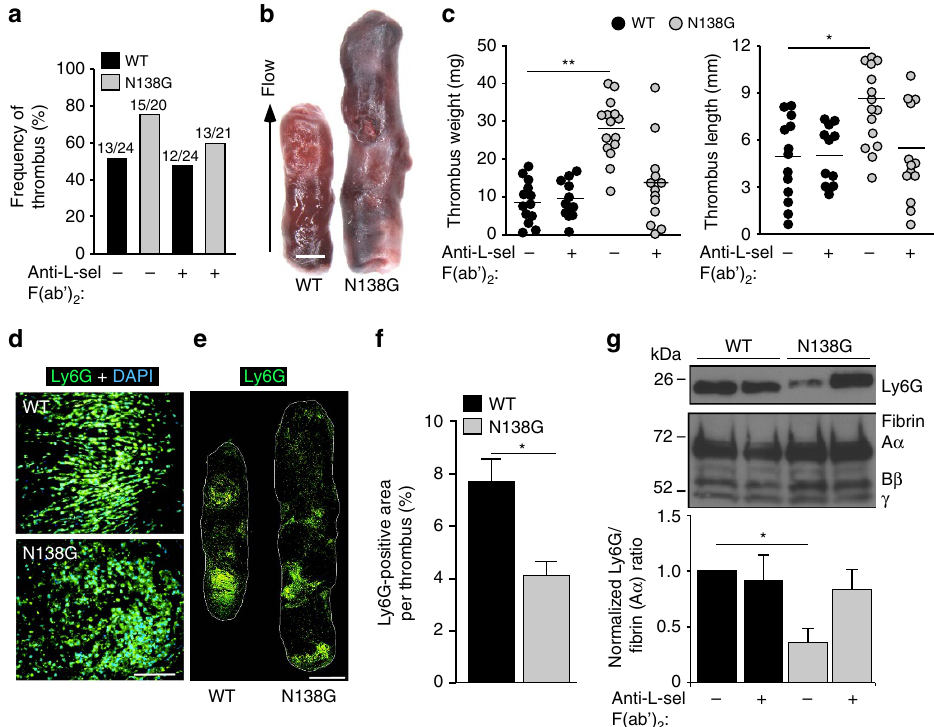
Figure 7 | N138G mice form larger deep vein thrombi. ( a ) Frequency of thrombi formed in inferior vena cava 48h after flow restriction in WTand N138G mice treated with or without anti-L-selectin F(ab 0 ) 2 . For each experimental group, the number of mice forming thrombi relative to the total number of mice is shown. ( b ) Representative thrombi. Arrow indicates direction of blood flow. Bar, 1mm. ( c ) Thrombus length and weight in WTand N138G mice treated with or without anti-L-selectin F(ab 0 ) 2 . Each symbol represents an individual thrombus. Horizontal bars represent median values. ( d ) Representative cryosections of leukocyte-rich areas of thrombi stained with anti-Ly6G mAb to identify neutrophils and with DAPI to identify cell nuclei. Bar, 100 m m. ( e ) Stitched cryosections of entire thrombus stained with anti-Ly6G mAb. Bar, 1mm. ( f ) Percentage of Ly6G-positive area per thrombus area in stitched sections. Data are mean ± s.e.m. from seven mice per group. ( g ) Upper panel, representative western blot of thrombus lysates probed with antibodies to Ly6G and fibrin. The A a , B b and g chains of fibrin are marked. The full-length blot is shown in Supplementary Fig. 8. Lower panel, normalized densitometric ratio of Ly6G to fibrin A a chain. Data are mean ± s.d. from eight mice per group. * P o 0.05; ** P o 0.01 (two-tailed Student’s t